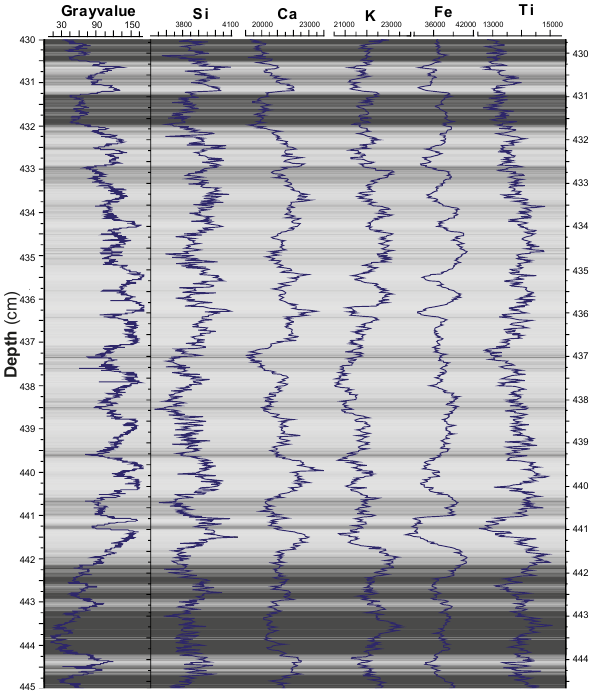
Figure 5. Seasonal-scale changes in chemical element composi- Fig. 5. Seasonal-scale changes in chemical element composition: high-resolution X-ray 3 tion: high-resolution X-ray fluorescence scanner data (area counts) fluorescence scanner data (area counts) every 0.2 mm of PS1795 core section (430 – 445 cm). 4 every 0.2mm of PS1795 core section (430–445cm). Additionally, Additionally, the estimated grey scale value curve estimated from scanned X-radiograph 5 the estimated grey scale value curve estimated from scanned X- using the BMPix tool (Weber et al., 2010) was added. 6 radiograph using the BMPix tool (Weber et al., 2010) was